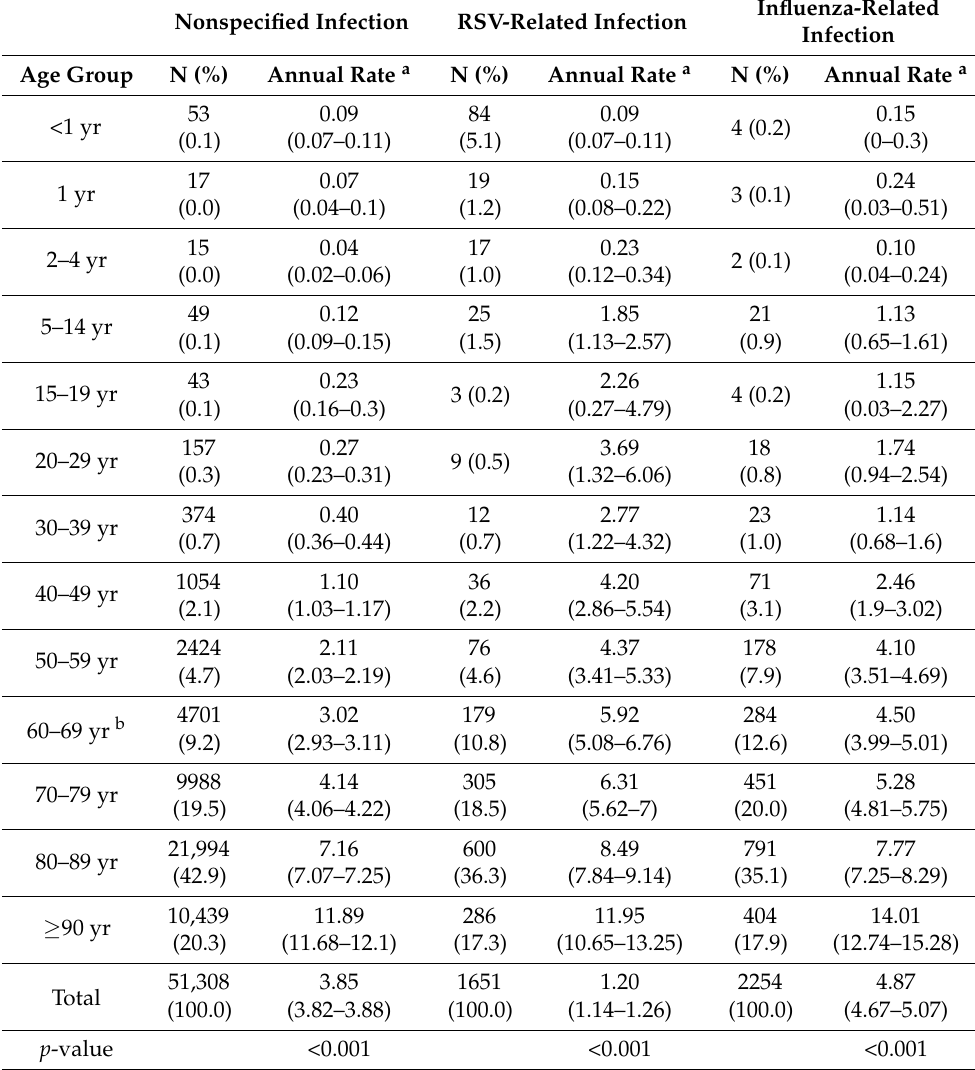
Table 5. The in-hospital case fatality rate in the general population in Spain by age group and diagnostic group between 2012 and 2020.